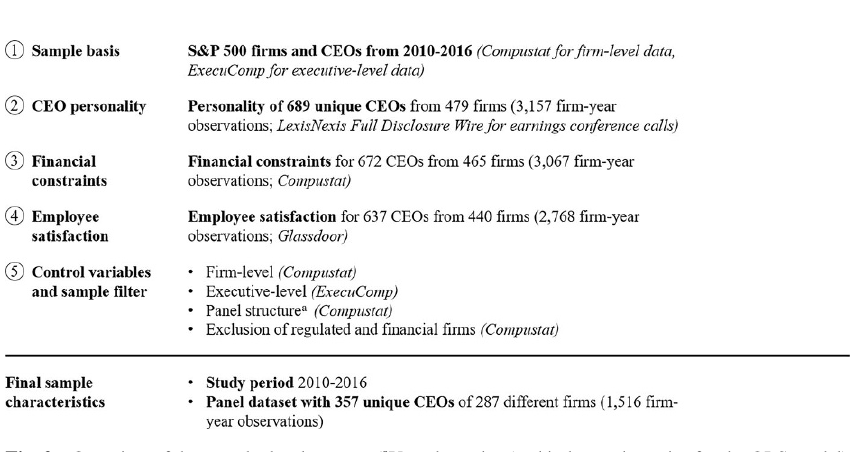
Fig. 2 Overview of the sample development. ( a Year dummies (and industry dummies for the OLS model) included to control for the dataset’s panel structure). (Source: own illustration)